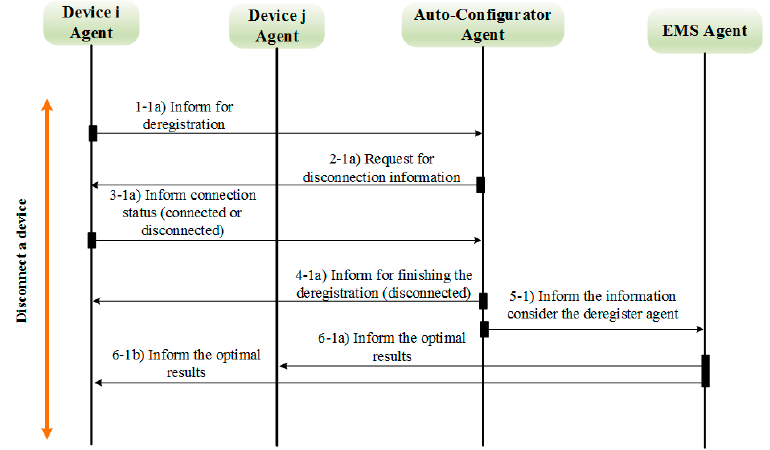
Figure 6. Sniffer diagram for disconnecting a device.